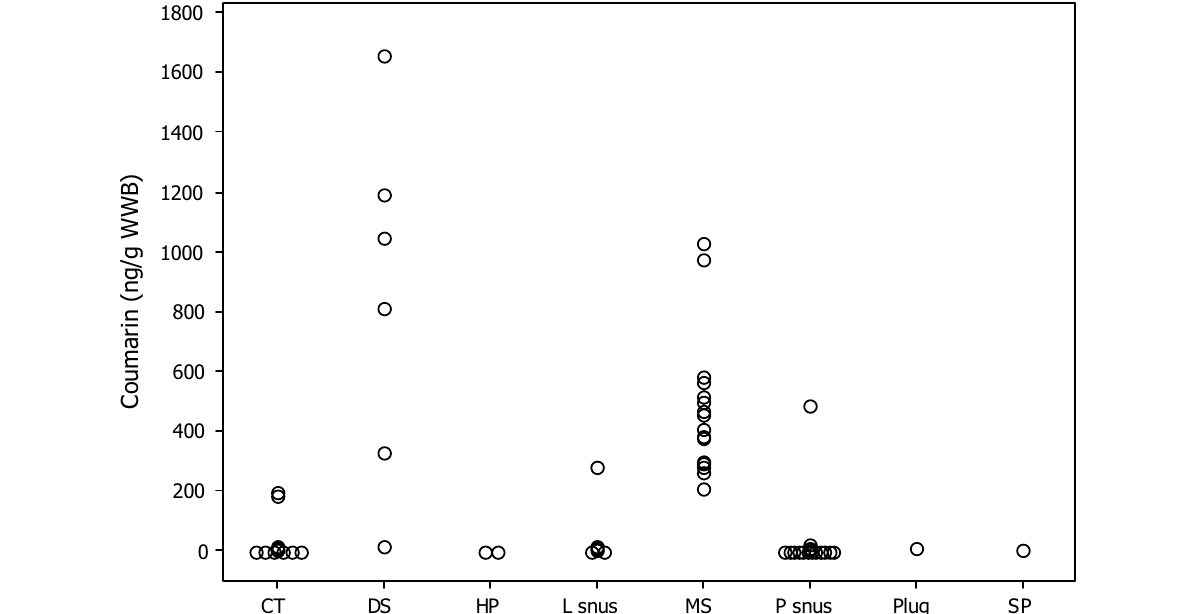
Fig. 3 Individual value plot: coumarin concentrations (ng/g STP WWB) by STP style. Concentrations < LOD or < LOQ are shown as